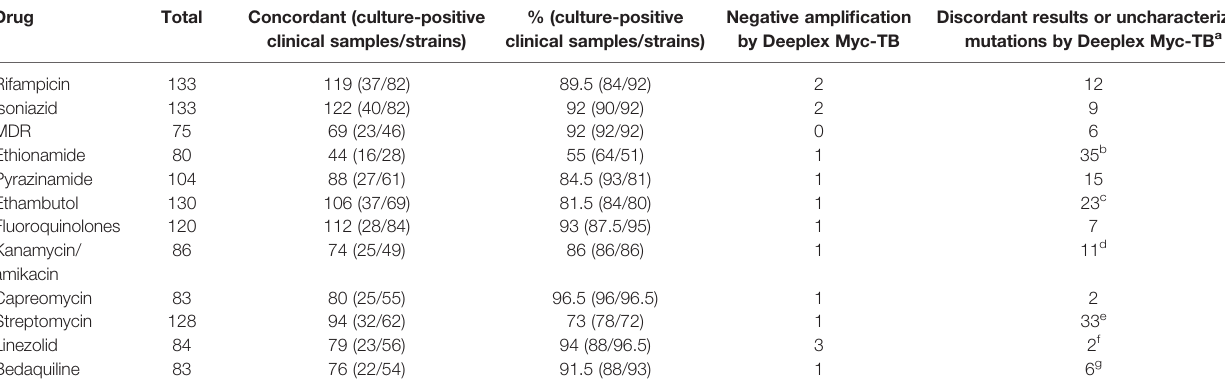
a Mutations detailed on Supplementary Table 1 . b Including one discrepancy between a -15 c->t mutation in the inhA promoter and the ETH-S DST result for one strain. c Including 11 EMB-R-conferring mutations giving discrepant results (EMB-S) with DST (M306I, G406A or D, D354A, Q497R, S297A, and Y319S). d Including four discrepancies between Deeplex Myc-TB and DST at the level of the eis promoter positions -10g->a (n = 1), -14c->t (n = 1), and -37g->t (n = 2), and 5 in rrs at